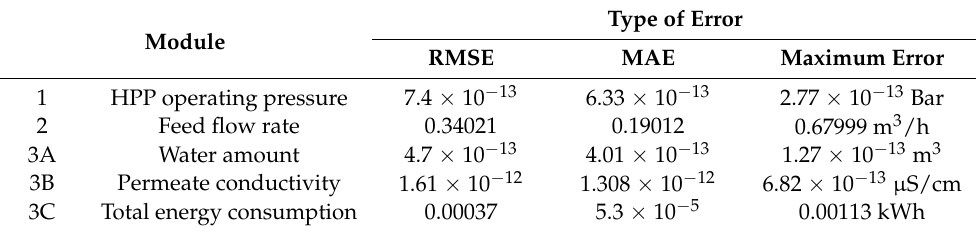
Figure 5. ( a ) Errors according to the RMSE metric in the system’s five modules; ( b ) similar graph to the previous one, ignoring module 3B, to observe the error more clearly in the other modules. Table 6. Error checking through the test group (remaining 10% of